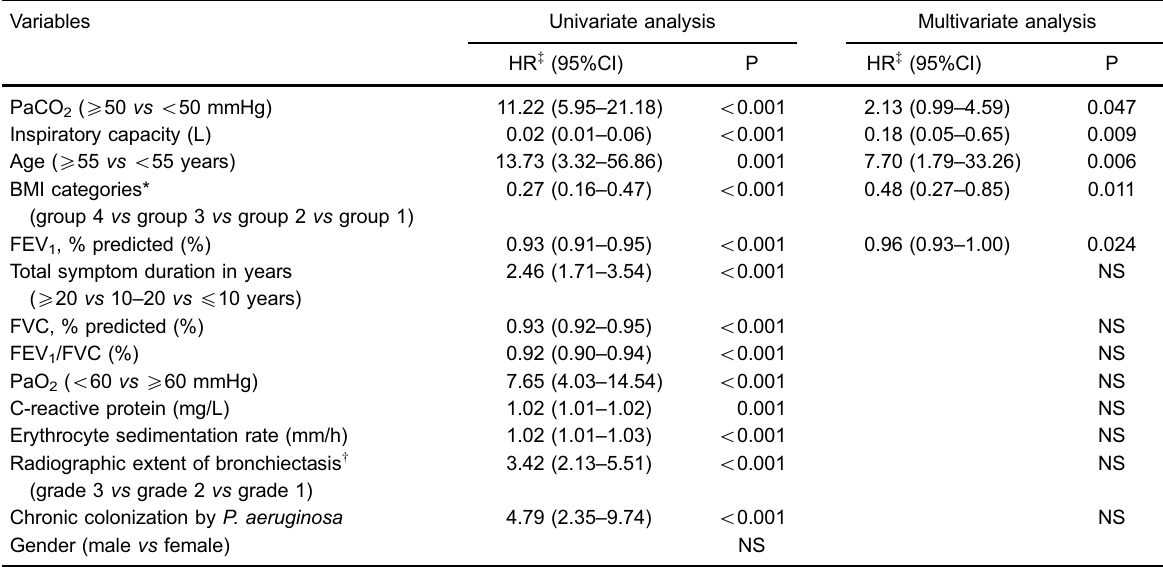
Figure 1. Differences in the cumulative survival curves among the four groups. The cumulative survival curves were statistically different among the four groups according to the log-rank test ( w 2 =31.67, P o 0.001). Mortality gradually increased as BMI decreased according to a trend test ( w 2 =35.16, P o Table 5. Predictive factors of mortality according to Cox proportional hazard model. Variables